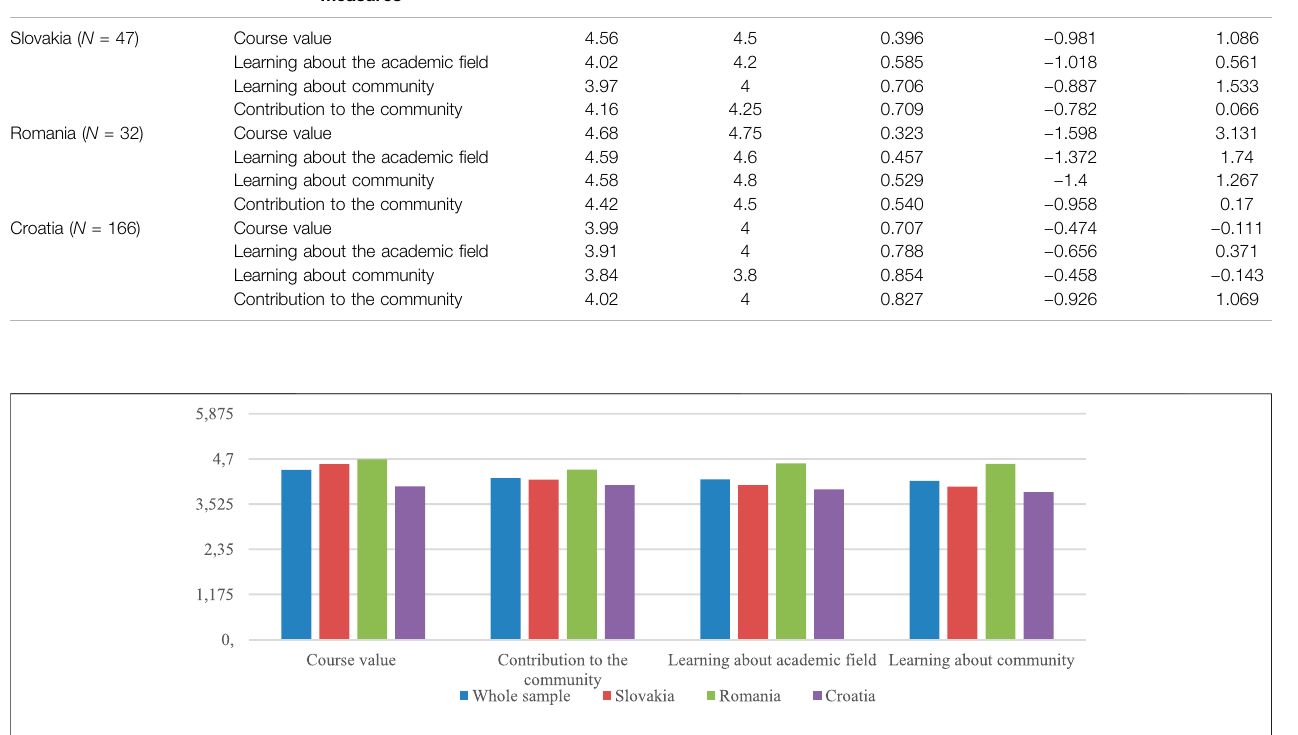
TABLE 4 | Comparative analysis of the SL course assessment between countries (Kruskal Wallis test). Subscale Course value Learning about the Learning about community Contribution to community academic fi eld Chi-square 47,521